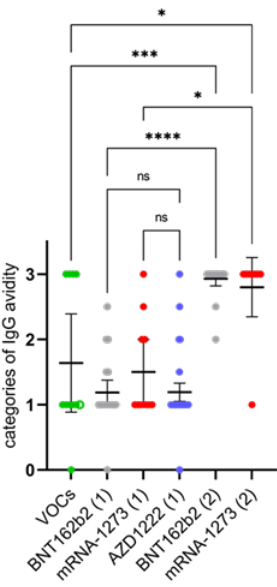
Figure 3. Development of immunoglobulin G (IgG) avidity after infection with SARS-CoV-2 variants